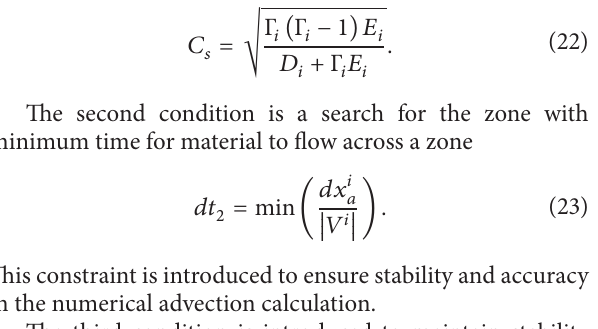
Figure 2: Comparison of the orbital angular velocity 𝜔 versus time for different values of the Courant parameter 𝑘 . As can be seen, the simulations with 𝑘 = 0.25–0.5 result in stable runs that converge to the same value, implying that a smaller 𝑘 or equivalently a smaller 𝛿𝑡 is not necessary and would only use extra CPU time. For comparison, we plot a simulation with 𝑘 = 0.6 to show that the stability is lost for 𝑘 > 0.5 .